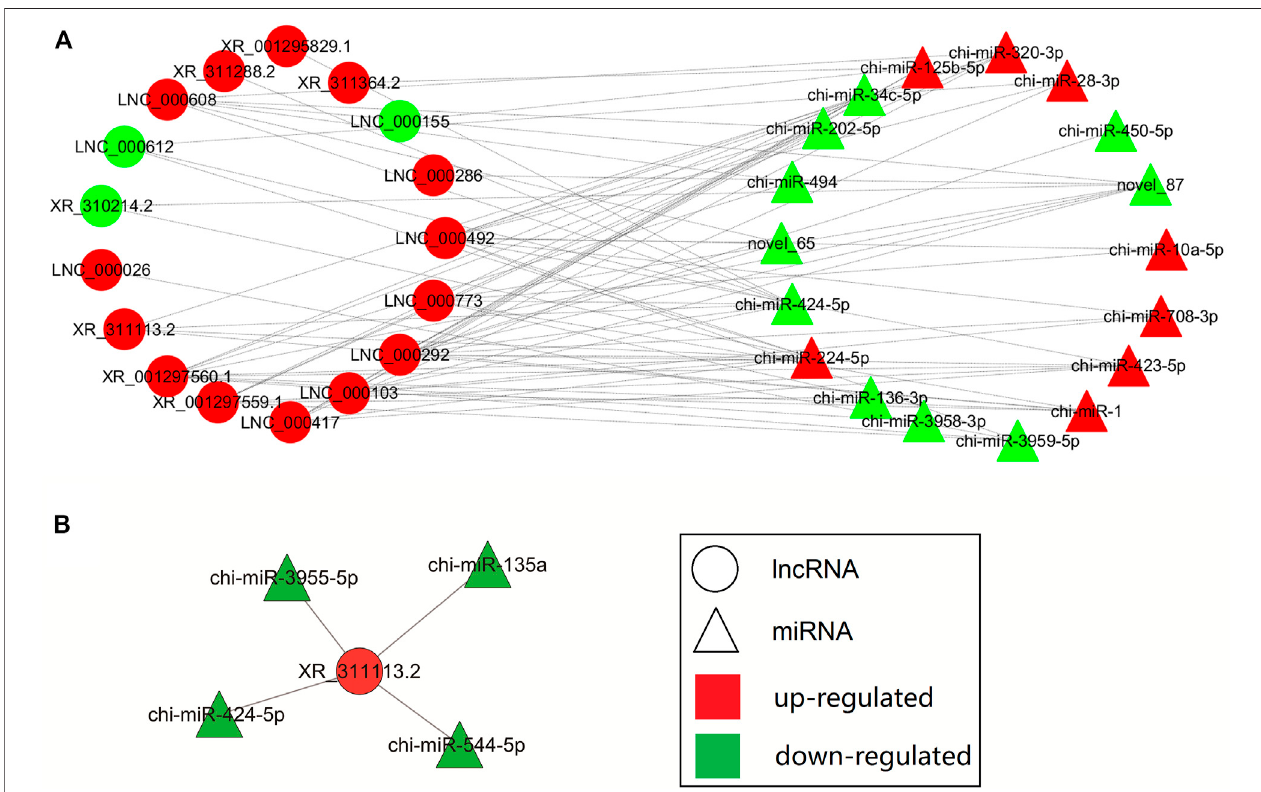
FIGURE 4 | Biomathematically predicted XR_311113.2 targeted in the lncRNA-miRNA network. The networks of lncRNA-miRNA were indicated by Cytoscape. Red: upregulated gene; green: downregulated gene; circle: lncRNA; triangle: miRNA. (A) The interaction network of the top 20 differentially expressed lncRNAs and mRNAs. (B) Predicted lncRNA-miRNA network of XR_311113.2 with four